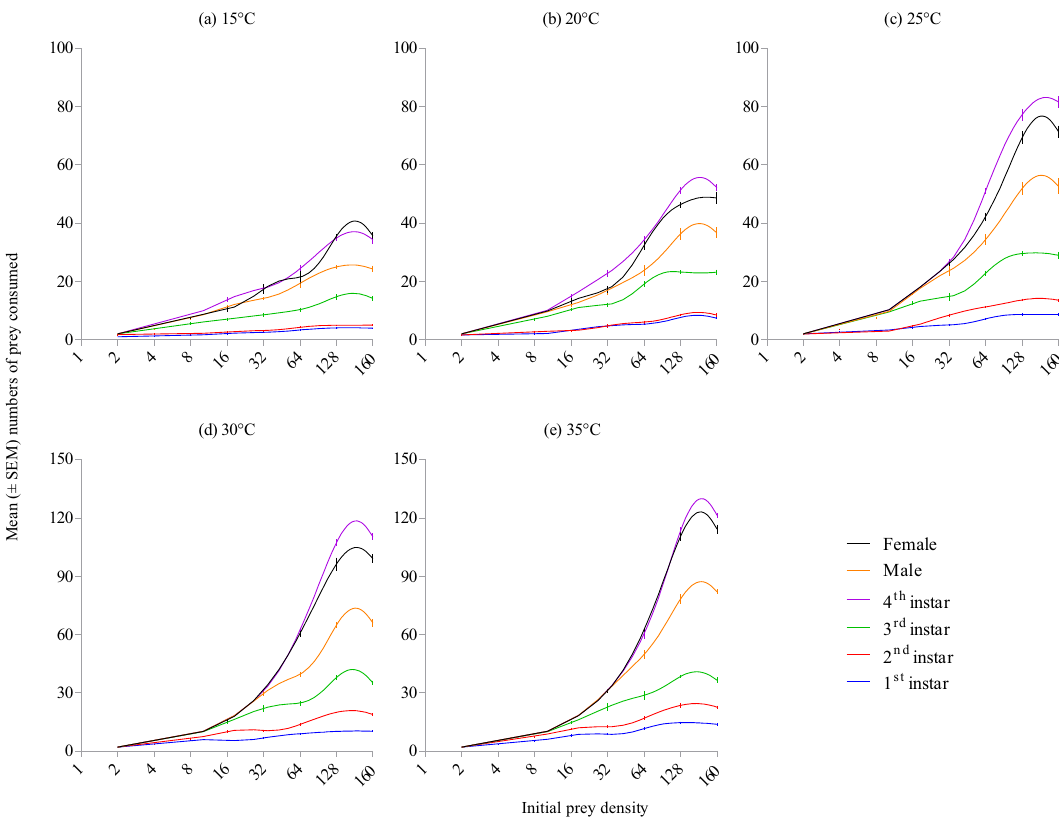
Figure 4. Mean (± SEM) numbers of Acyrthosiphon pisum nymphs consumed by various growth stages of Harmonia axyridis under different thermal conditions at different prey